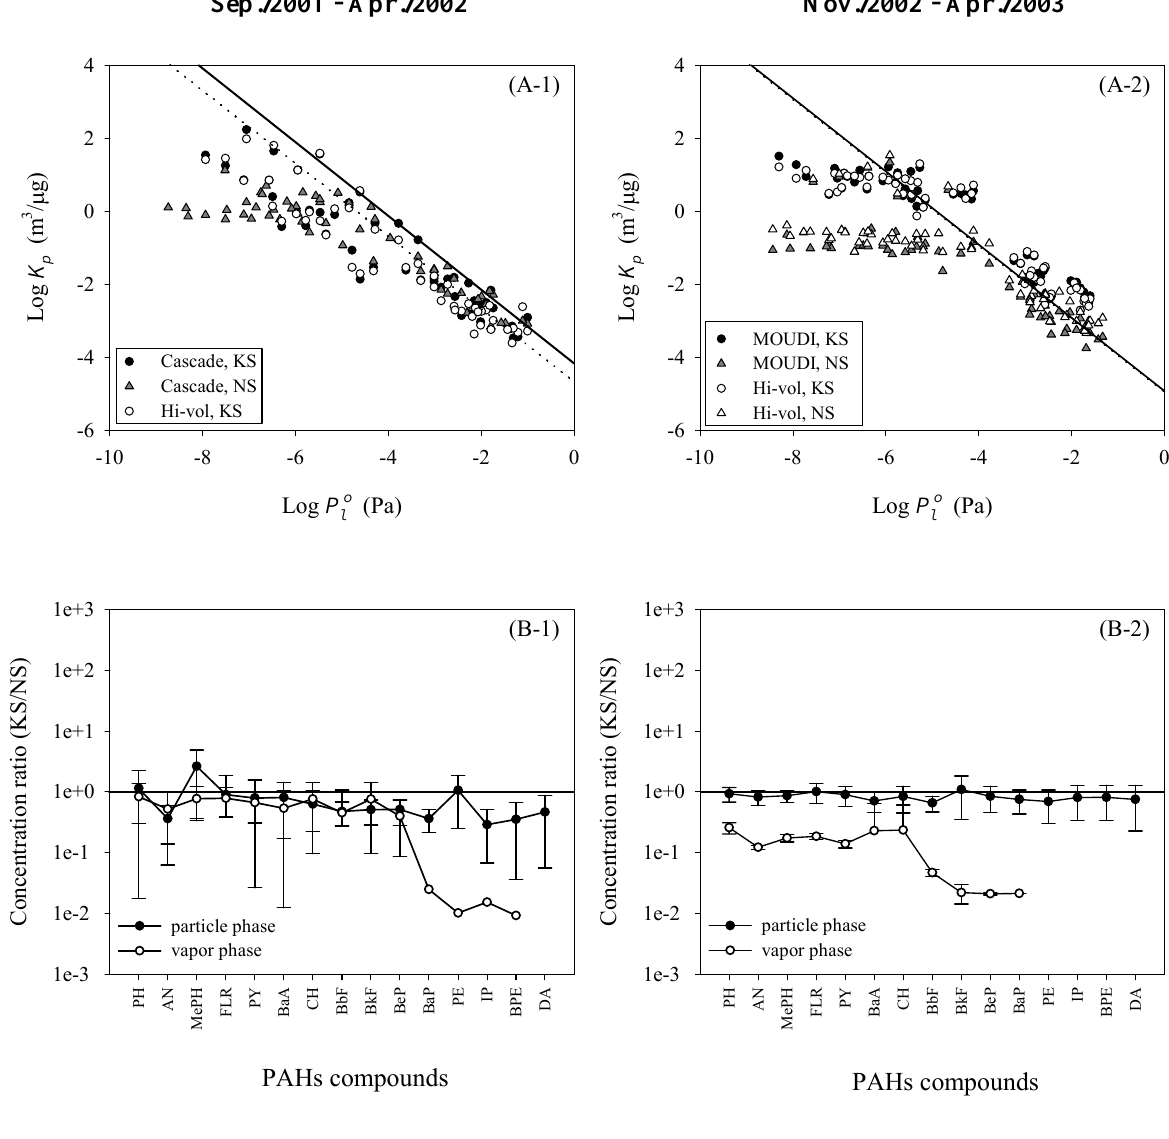
Figure 4. Comparison of (A) partition coefficients (K (KS, circles) and urban (NS, triangles) sites (Dotted and solid lines denote the mean K values predicted from Junge-Pankow model (Atmos. Envion. 1987, 21, 2275-2283) for KS and NS, respectively.) and (B) concentration ratio between the two